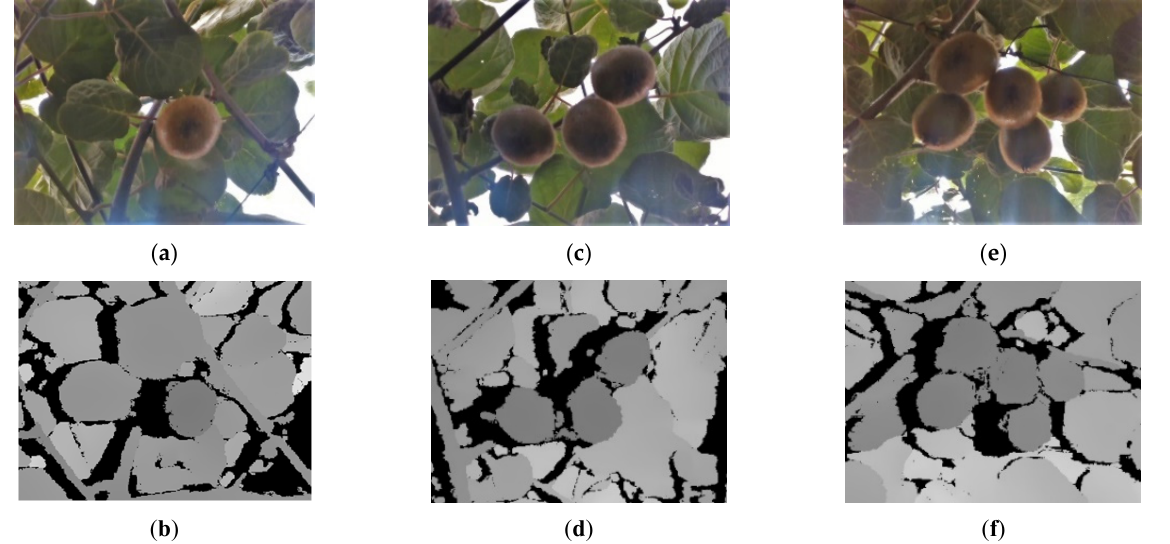
Figure 4. Kiwifruit images: ( a , c , e ) RGB images of single, linear cluster, and other cluster, respectively; ( b , d , f ) depth images corresponding to the previous.